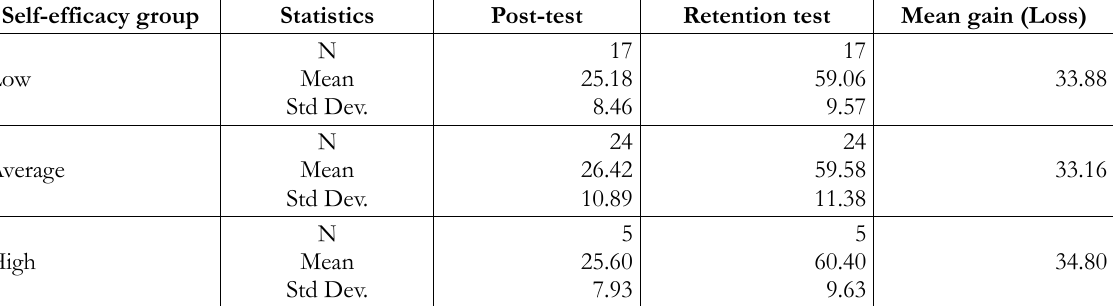
Table 6. Influence of self-efficacy on students’ retention